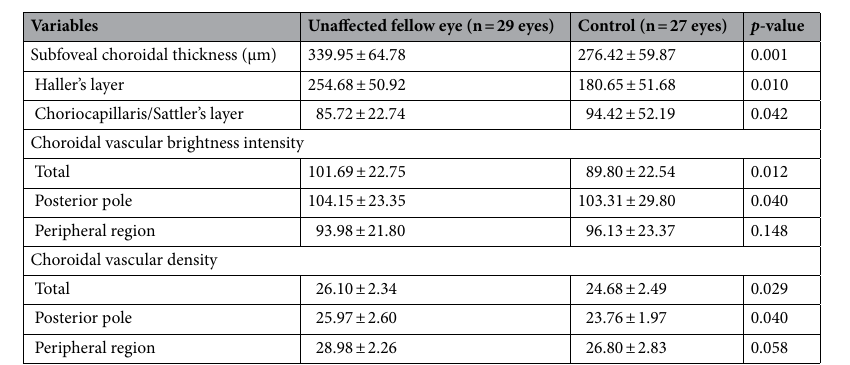
Figure 1. Comparative analysis of choroidal vascular brightness intensity (CVB) between affected left eye and unaffected right eye in a 66-year-old male patient with unilateral PCV. The original ICGA image of affected left eye was cropped to remove the areas obscured by the eyelashes ( A ). The images were adjusted based on the brightness of the retinal blood vessels at the optic nerve location to compensate for the difference in brightness between the images of each patient ( B ). Image thresholding method was applied to extract enhanced pixels. This method was used to extract the brightness of only the choroidal vessels. The mean CVB of entire fundus converted to 8-bit gray scale was 112.56. The CVB of affected left eye in the posterior pole and peripheral region were 118.15 and 95.08 respectively ( C ). The same image processing was applied to the unaffected right eye of the same patient ( D – F ). The mean CVB of entire fundus in unaffected right eye was 102.75. The CVB of unaffected right eye in the posterior pole and peripheral region were 105.39 and 94.96 respectively.